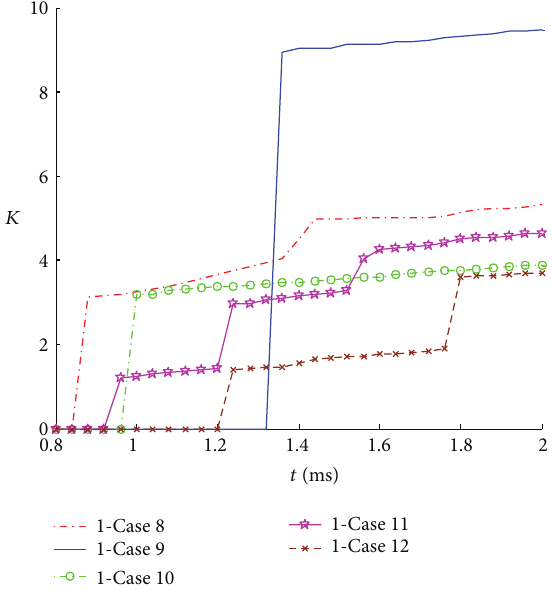
Figure 20: The crevasse variation of inner shell without interlayer water; cases are shown in Table